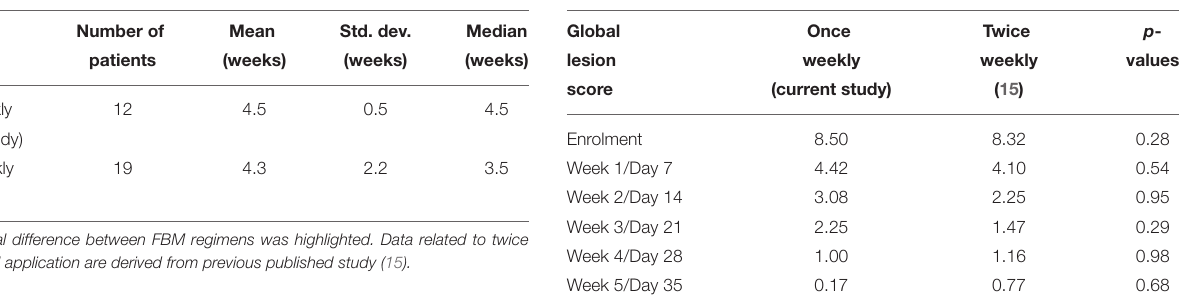
TABLE 5 | Summary of GLS values between once and twice weekly FBM